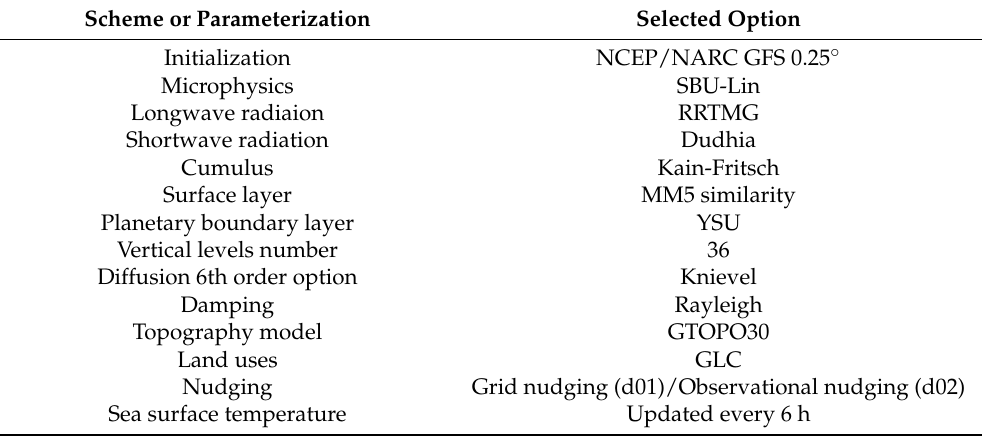
Table 2. Configuration options selected for the WRF simulations, based on